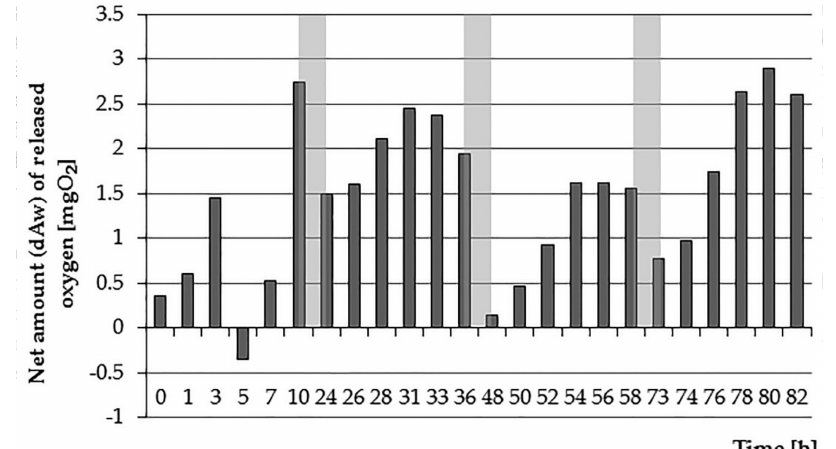
Figure 2. Net oxygen amount dA w introduced into the water by E. densa in 4 days of analysis (periods of nighttime—without measurements—marked as grey zones).